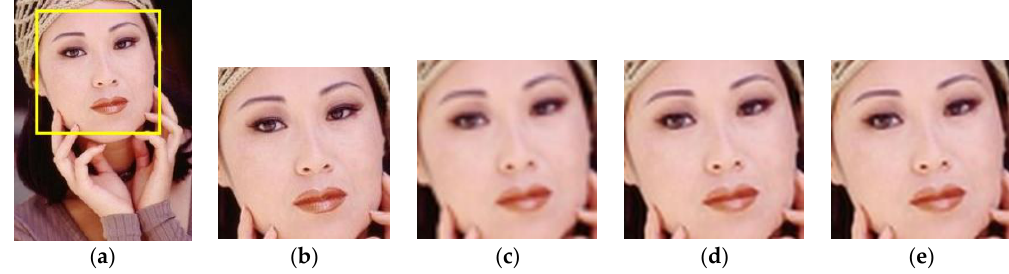
Figure 6. Comparison of the reconstructed images with three SR algorithms for Woman . ( a ) Woman; ( b ) Reference; ( c ) Bicubic; ( d ) SRSAE; ( e ) SRISAE. Table 2. Comparison of the average PSNR(dB) and SSIM values of the reconstructed images with the three super resolution (SR) algorithms for Set5, Set14, and BSD100 (PSNR/SSIM). SRSAE: SR algorithm based on the SAE; SRISAE: SR algorithm based on the ISAE. Images Bicubic SRSAE SRISAE Set5 30.40/0.8953 32.16/0.9234 32.37/0.9263 Set4 27.54/0.8107 28.90/0.8487 28.99/0.8503 BSD100 27.15/0.7775 28.03/0.8169